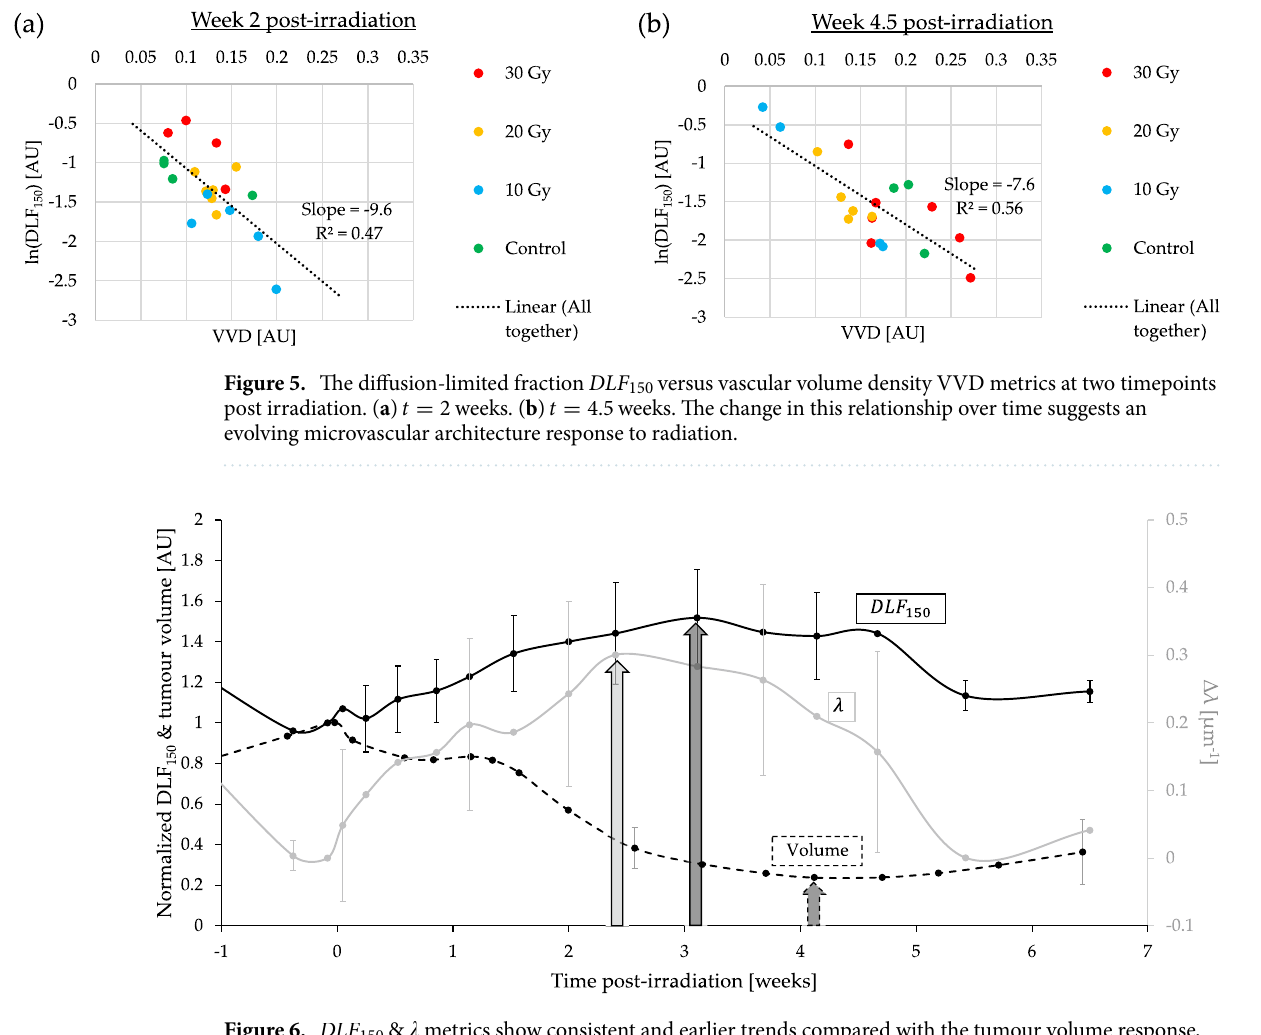
Figure 6. DLF 150 & (cid:31) metrics show consistent and earlier trends compared with the tumour volume response, showing promise as candidate predictive biomarkers. The mean normalized DLF 150 (solid black, left y-axis) 6 ) seem to precede the temporal evolution of the and λ (solid grey, right y-axis) for the 30 Gy treated mice ( n = mean normalized tumour volume (dotted black, left y-axis). Arrows represent approximate time-to-peak in response maxima and minima, respectively. Error bars represent standard